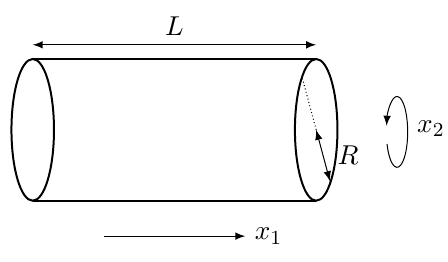
Figure 2 . A (cid:12)nite cylinder of length L and radius R